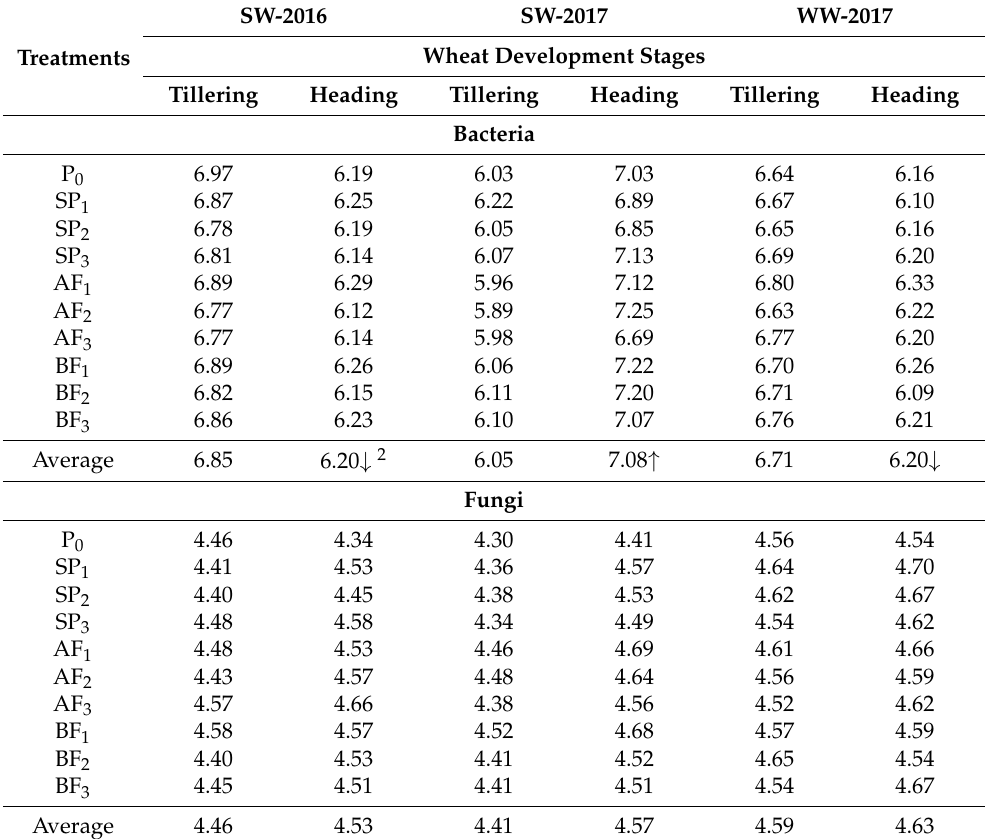
Table 11. Abundance of heterotrophic bacteria and fungi in the 0–30 cm layer of soil, Log 10 (CFU + 1) per 1 g of soil DM 1